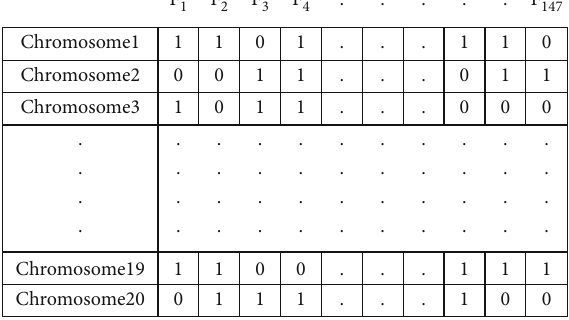
Figure 2: Binary encoding of the feature selection (population), where each chromosome represents an individ- ual solution. After generating the initial population, genetic operations such as chromosomes mutation and crossover are performed to generate o ff spring. A fi tness function is then used to select best chromosomes that will be fed to the next iteration. This process repeats until certain number of itera- tions is reached, or a solution of acceptable quality, or fi tness value, is found [32].